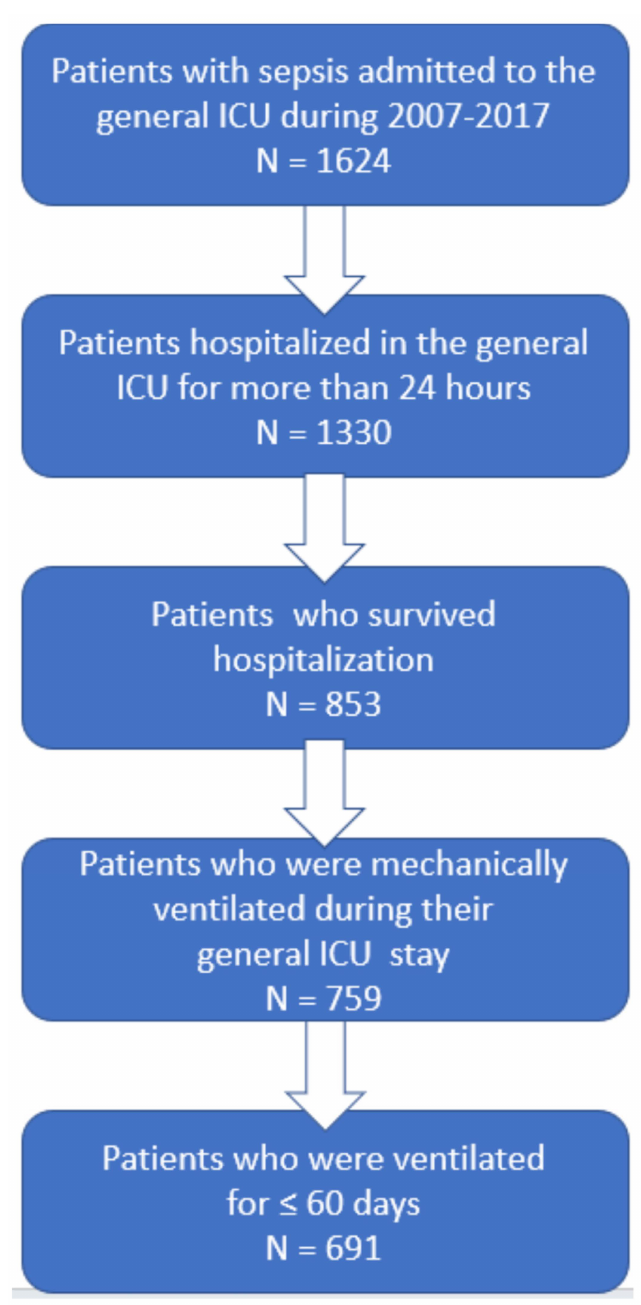
Figure 1. The patient flow chart, according to the study inclusion